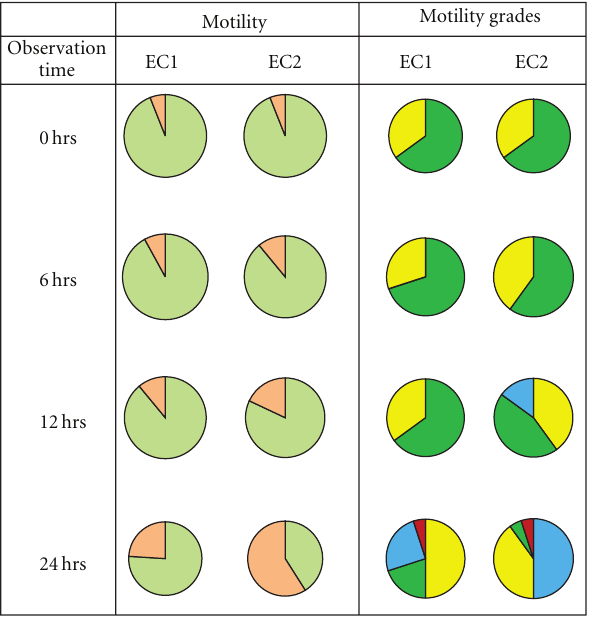
Figure 3: Change pattern in motility (motile: olive green; non- motile: light orange) and motility grades (G4: green; G3: yellow; G2: blue; G1: red) in AAB-PT event 09 − E 2 samples (EC1 and EC2) during sperm culture for 24